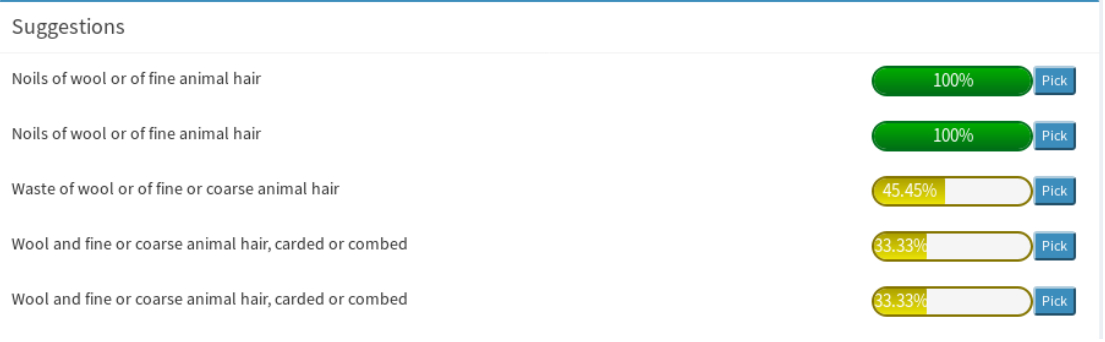
Figure 6. The system suggestions